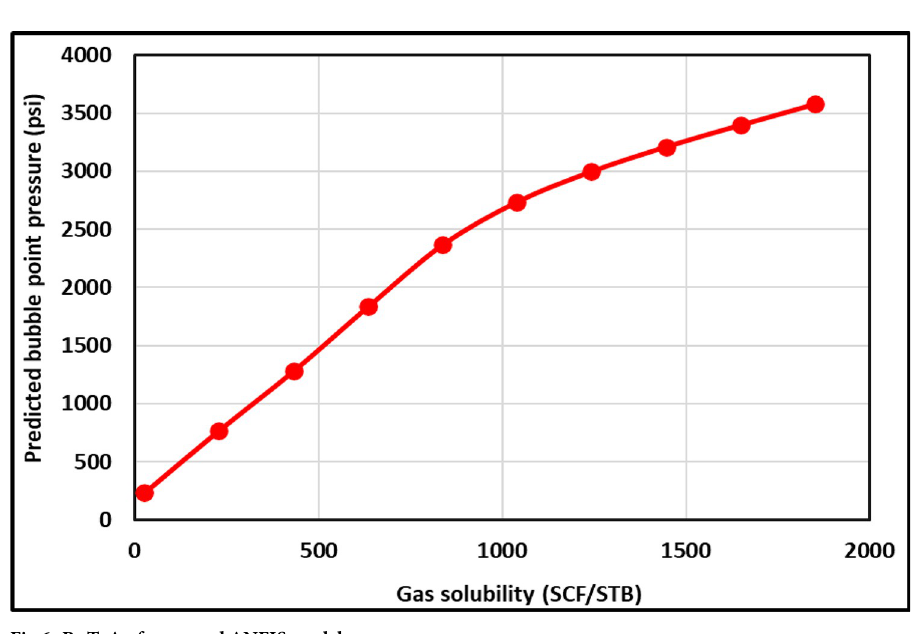
Fig 6. Rs TrA of proposed ANFIS